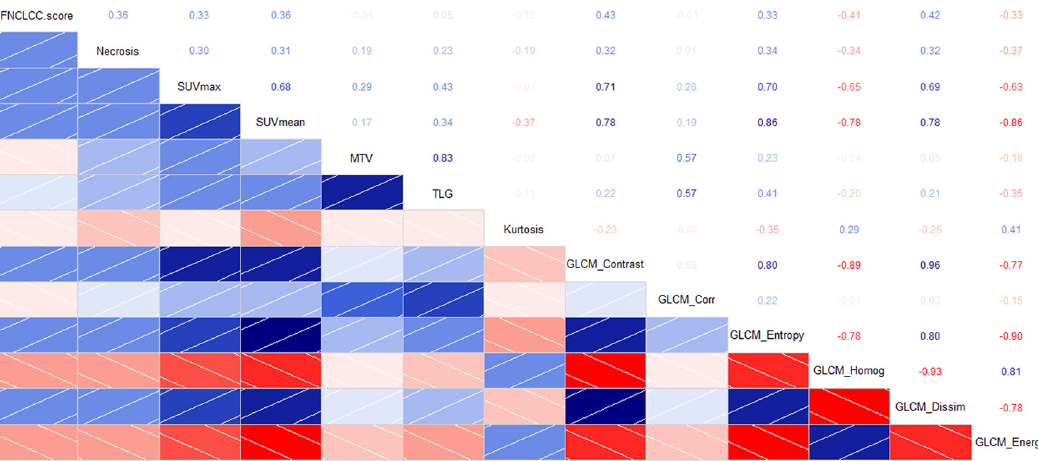
Figure 2. Correlogram including histologic, conventional PET metrics, first order and GCLM textural indices (lower left; blue = direct correlation; red = inverse correlation) with Kendall τ coefficients (upper right).